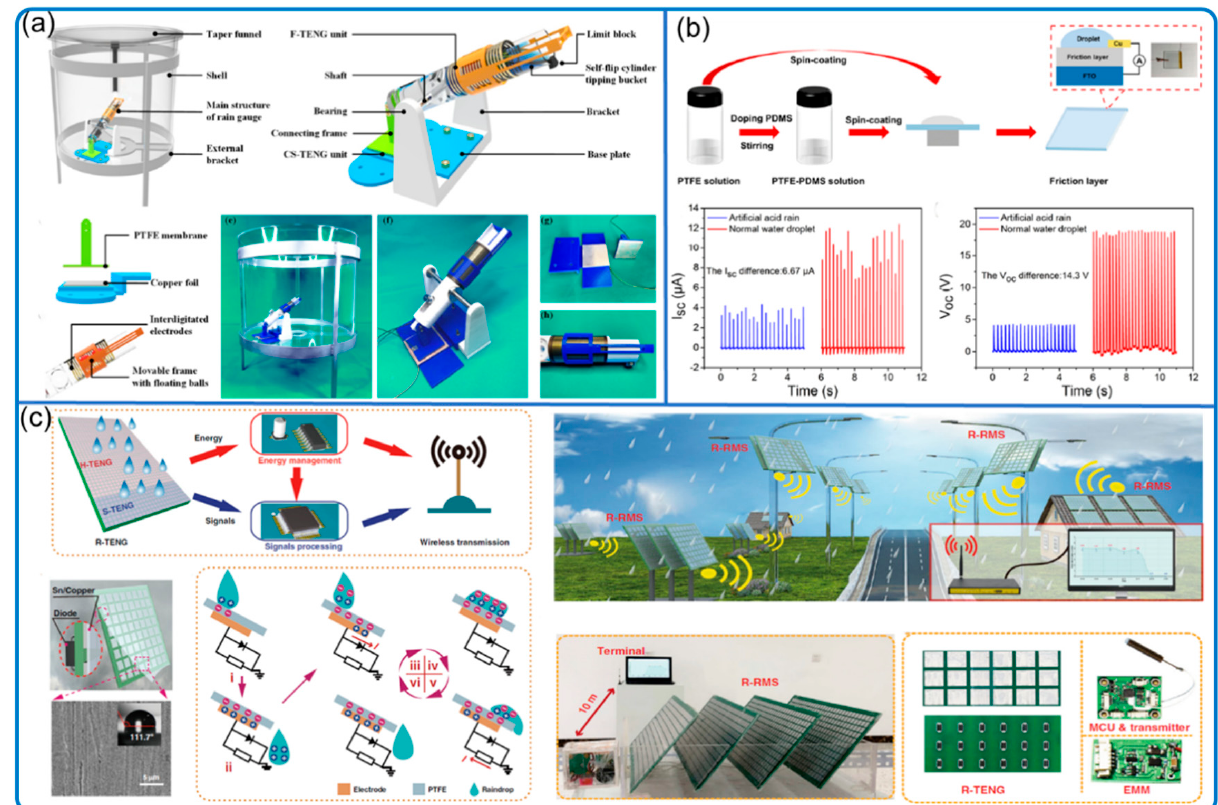
Figure 7. Rain monitoring TENG. ( a ) Tipping bucket rain gauge sensor. Reproduced with permission. Copyright 2022, Elsevier [53]. ( b ) Real-time acid rain sensor. Reproduced with permission. Copyright 2021, American Chemical Society [57]. ( c ) Raindrop-powered autonomous rainfall monitoring. Reproduced with permission. Copyright 2022, Springer [56].